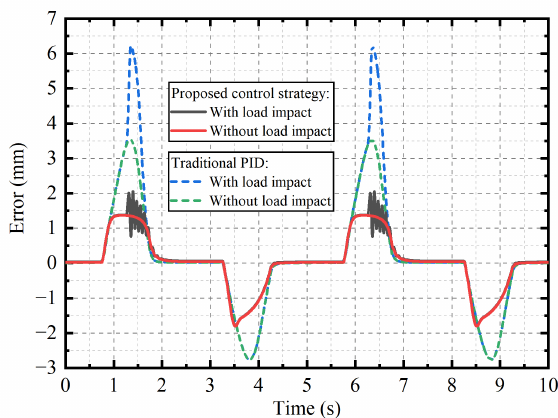
Figure 22. Tracking error under load impact.